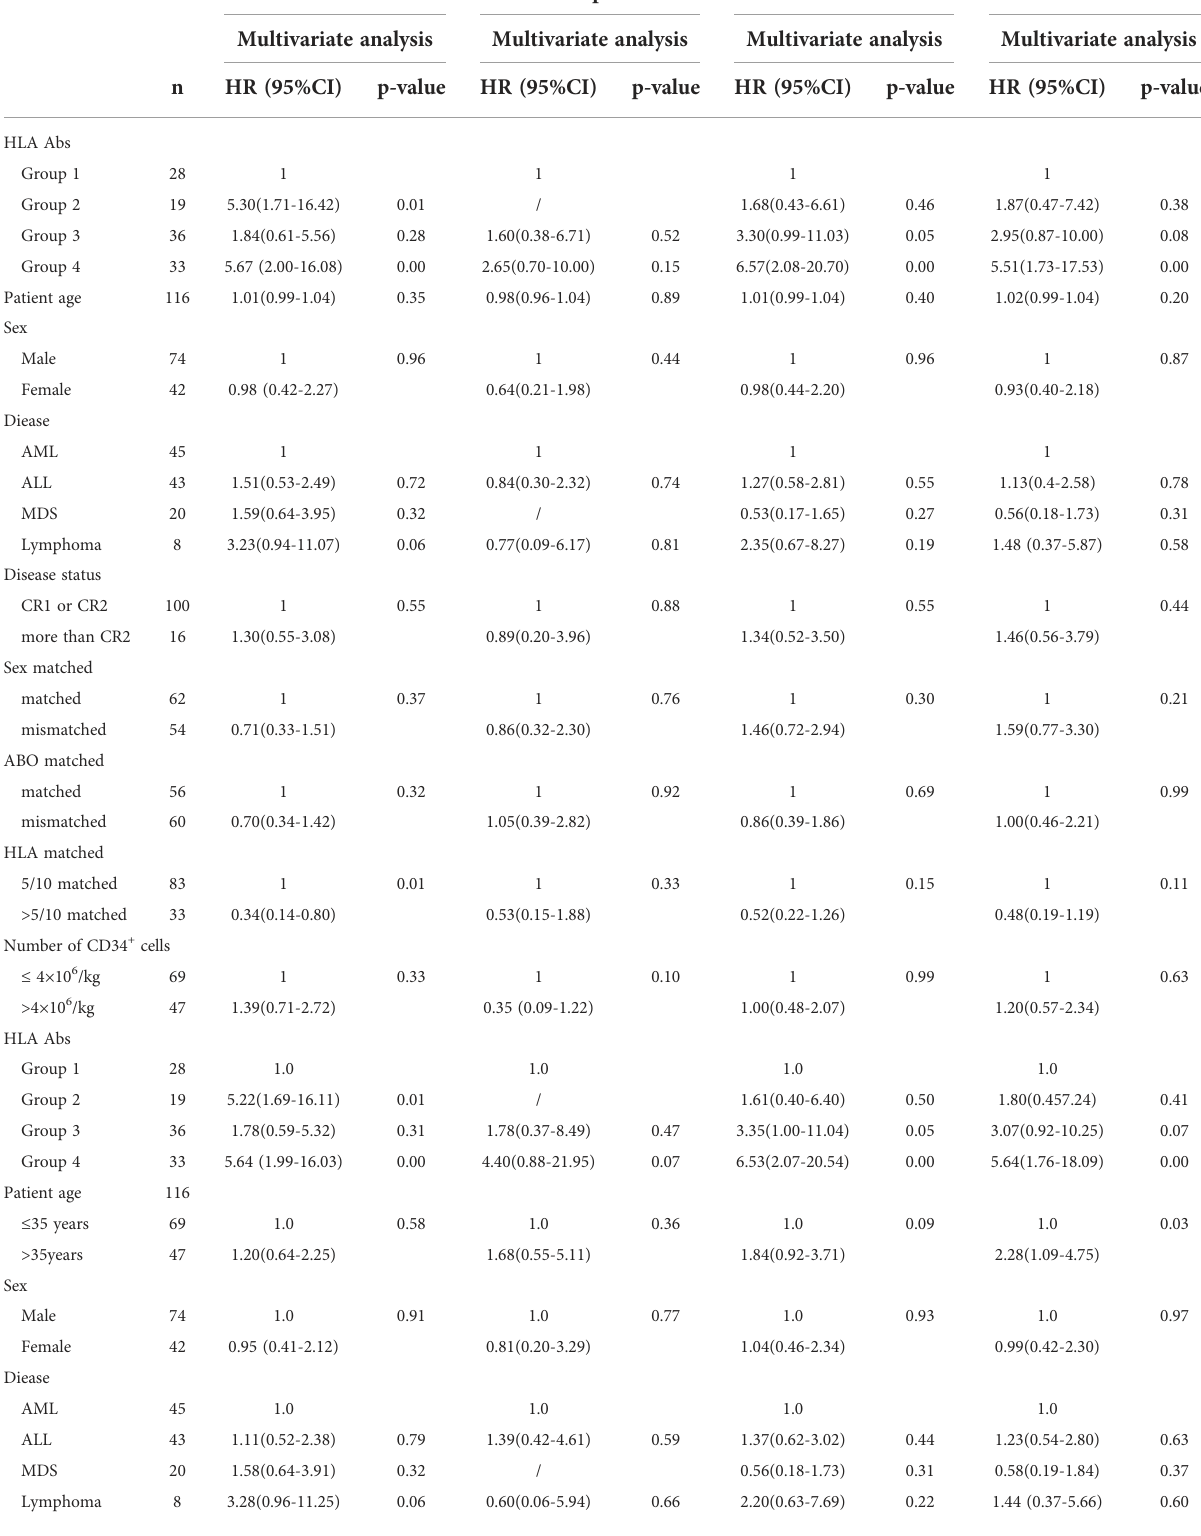
TABLE 4 Multivariate analysis of aGvHD, relapse, DFS and OS after haplo-HSCT in 116 patients with malignant hematological diseases. Factors aGvHD relapse DFS OS Multivariate analysis Multivariate analysis Multivariate